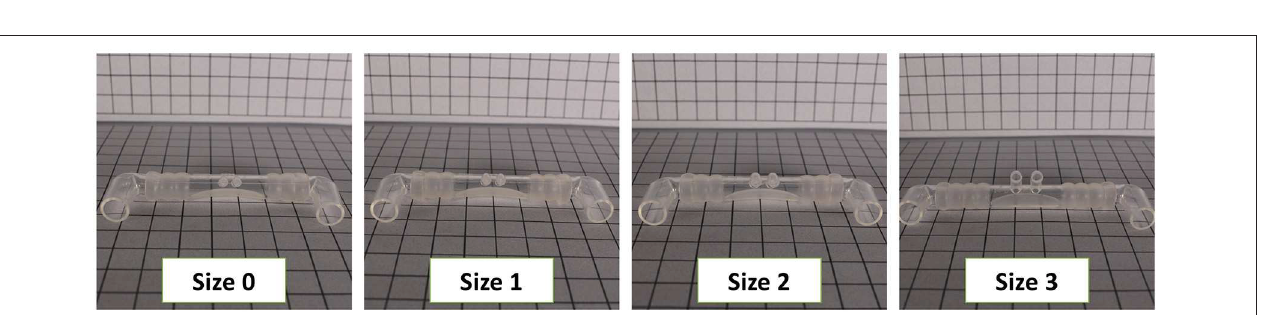
FIGURE 4 | Different nasal prong sizes are needed to achieve a seal. Shown are Sizes 0 through 3 of the Babi.Plus nCPAP system.